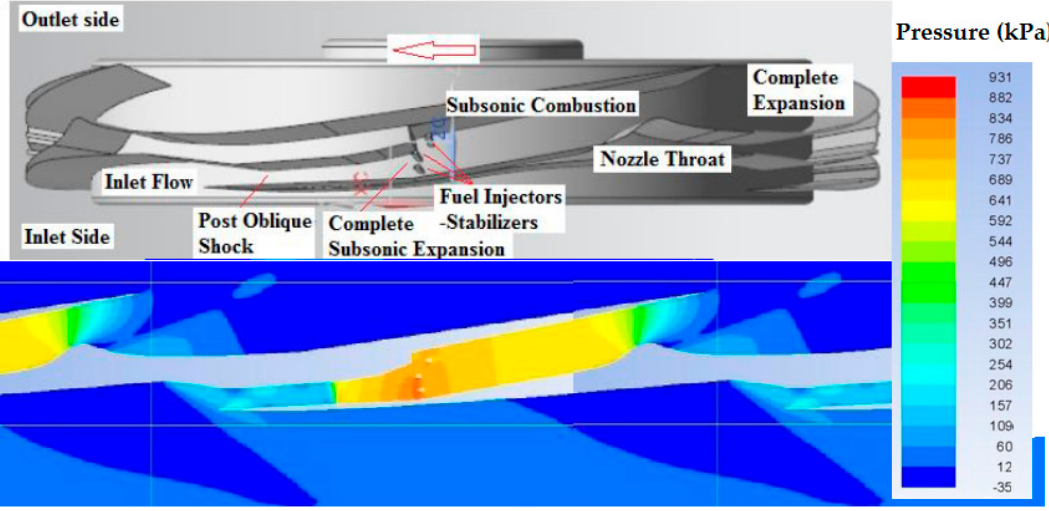
Figure 14. Geometry of the channels of one of the four engine segments and an example pressure distribution in the engine channels (Pa).